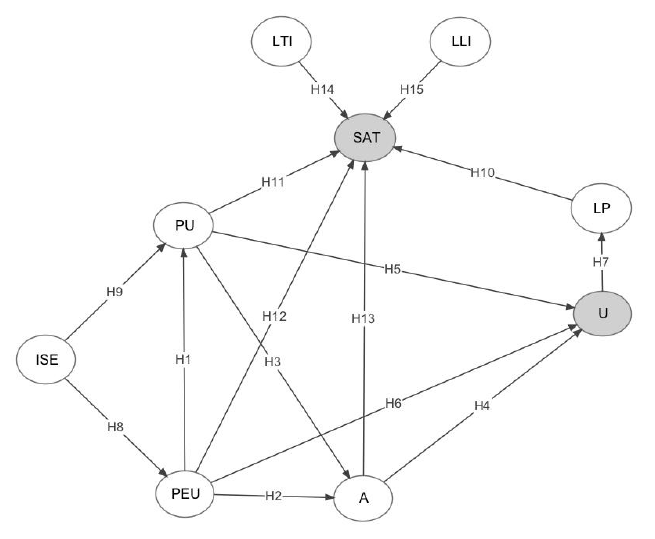
Figure 2. Research